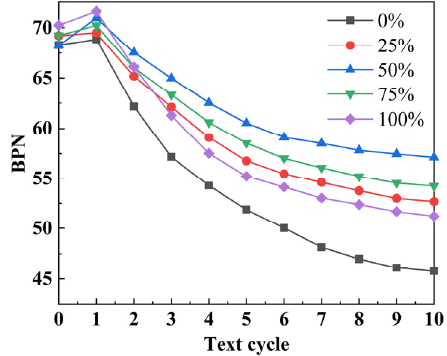
Figure 8. BPN attenuation curves of SSAM.